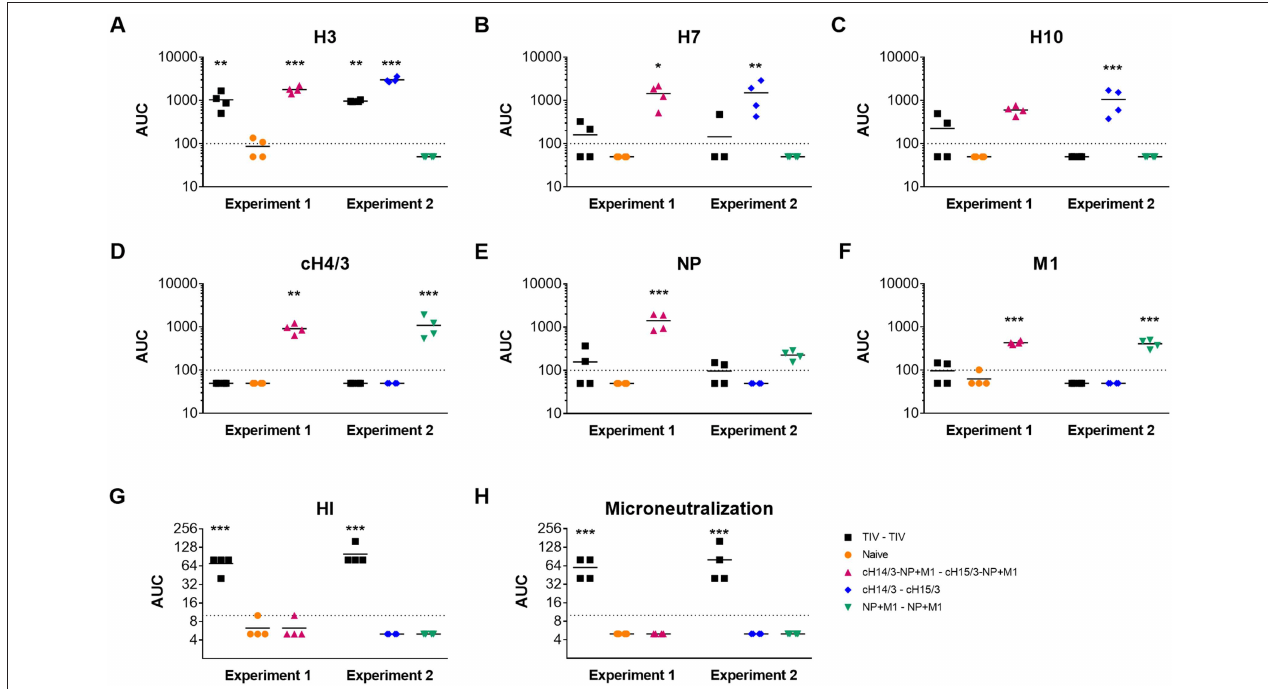
FIGURE 4 | Antibody responses toward influenza virus antigens in the pre-challenge serum of vaccinated ferrets. Six weeks after the booster vaccination, pre-challenge serum was collected from TIV vaccinated, viral vector vaccinated, and naïve ferrets and IgG antibody responses toward influenza virus antigens were assessed via ELISA. Shown are antibody responses toward the H3 (A) , H7 (B) , H10 (C) , cH4/3 (D) , NP (E) , and M1 (F) recombinant proteins. HI (G) and microneutralization titres (H) were also assessed. The data are presented as individual replicates and the mean for each group is presented as line. n = 4 ferrets/group. * p ≤ 0.05, ** p ≤ 0.01, *** p < 0.005 when naïve controls were compared to individual vaccination groups as determined by one-way analysis of variance, followed by a Bonferroni multiple-comparison